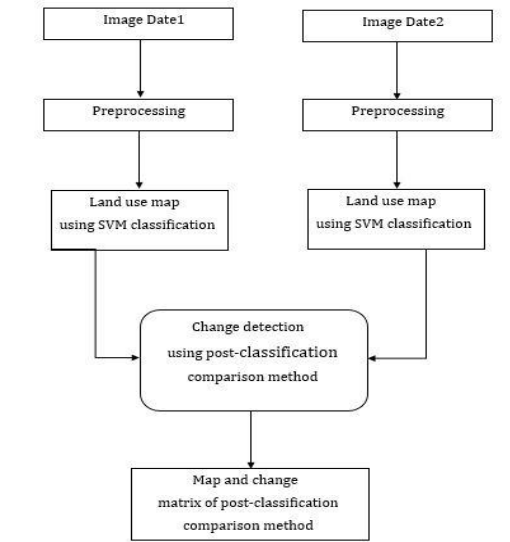
Figure 2. Flowchart of the proposed method